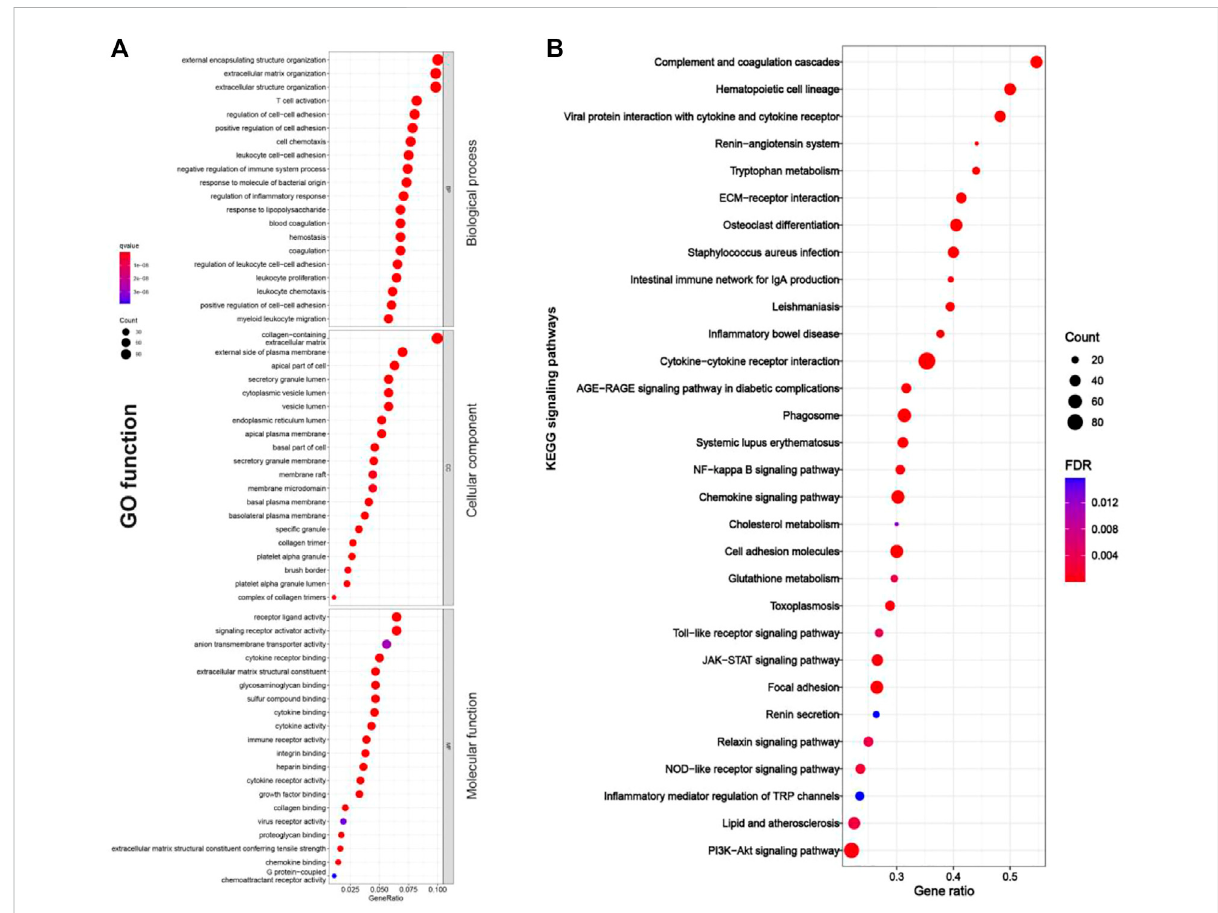
FIGURE 4 GOfunctionandKEGGpathwaysenrichmentresultsofRF-relatedDEGsintheadeninemodel. (A) BubblechartsofGOenrichmentanalysis,the Y axis displayed biological process, cellular component, and molecular function modules, the X axis represented gene ratio, count (the size of the nodes) indicated gene number, and qvalue (the intensity of the color) referred to -log10 p -value. (B) Bubble charts of 30 KEGG signi fi cant pathways with p < 0.05, the Y -axis displayed pathways, the X -axis represented gene ratio, count (the size of the nodes) indicated gene number, and FDR value (the intensity of the color) referred to -log10 p